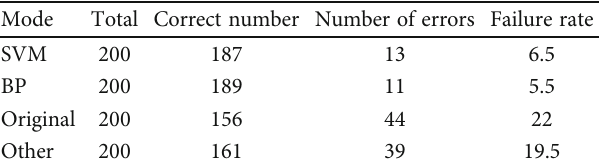
Table 4: Damage judgment in di ff erent modes.